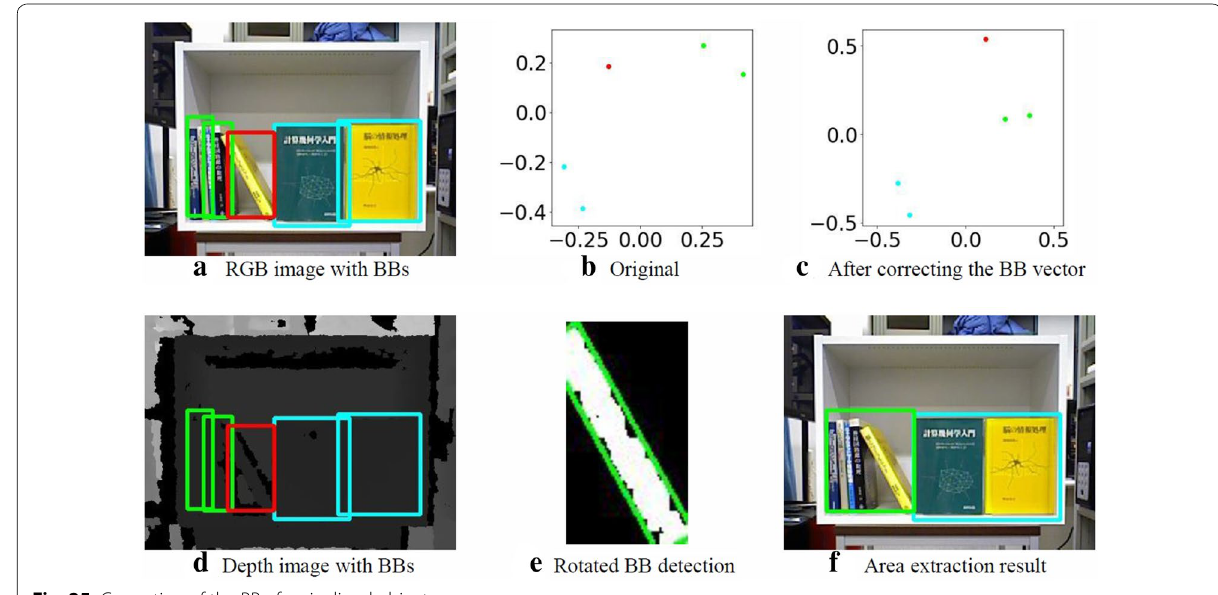
Fig. 25 Correction of the BB of an inclined